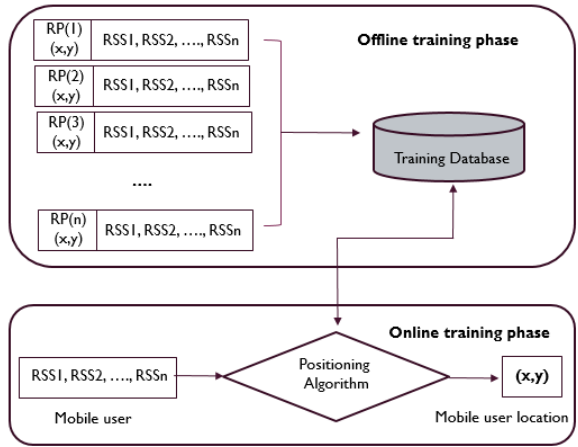
Figure 5. Fingerprinting based